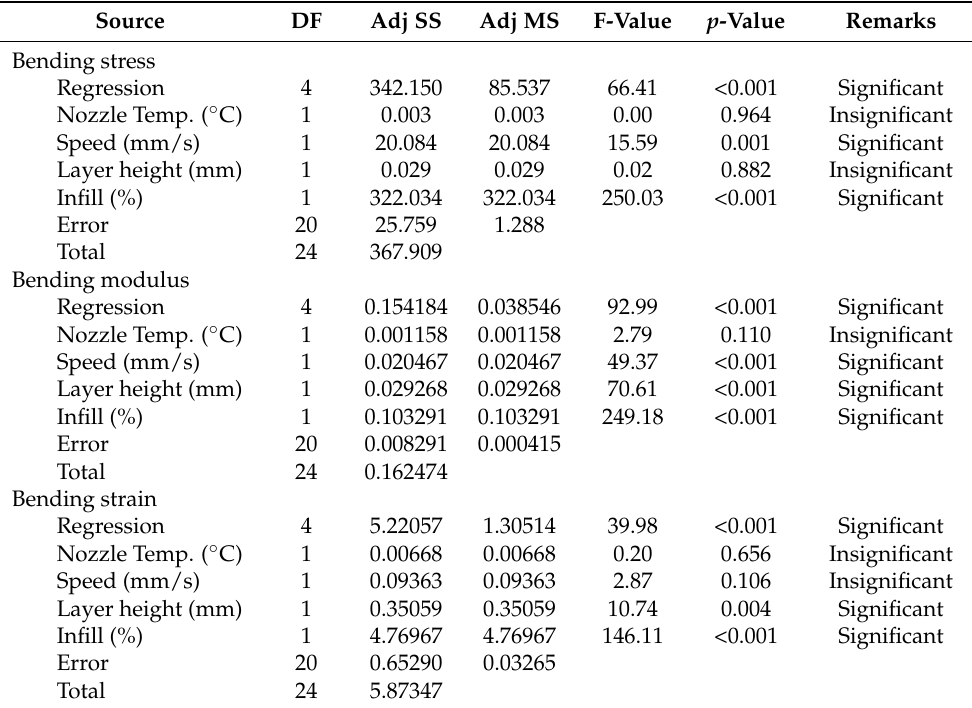
Table 9. ANOVA analysis for